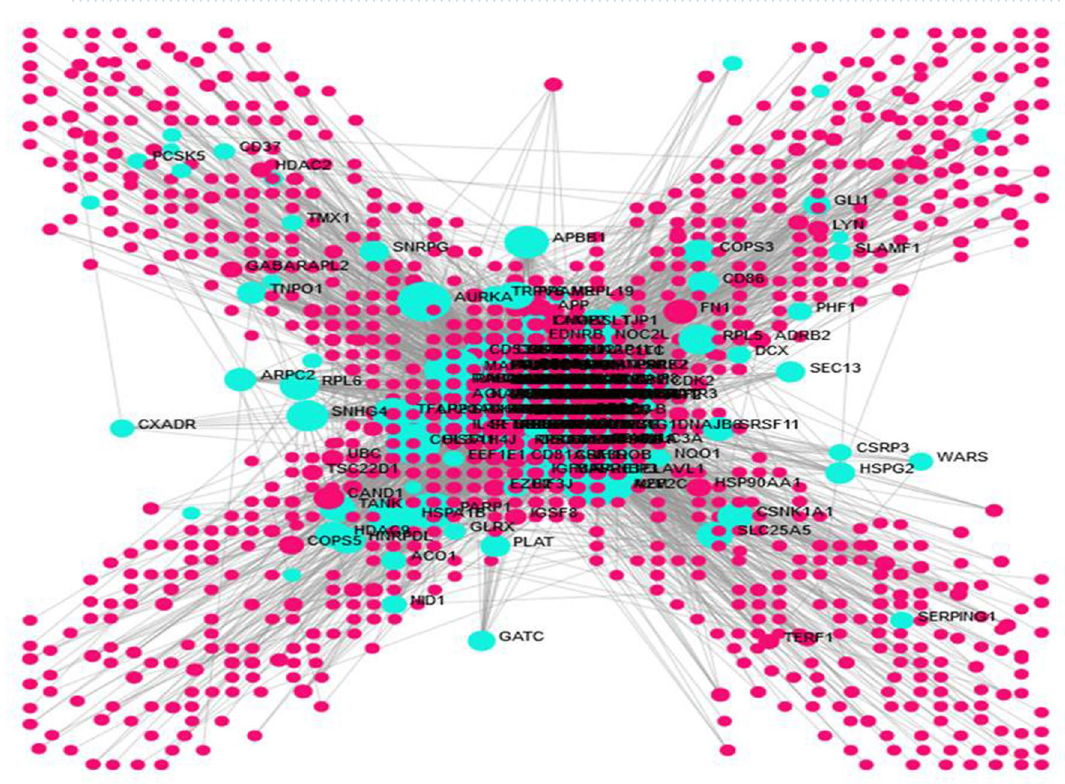
Figure 2. Tissue-specific PPI network for the differentially expressed genes. The green color represents the differentially expressed genes and the pink color spheres represent the interaction with various human immune responsive